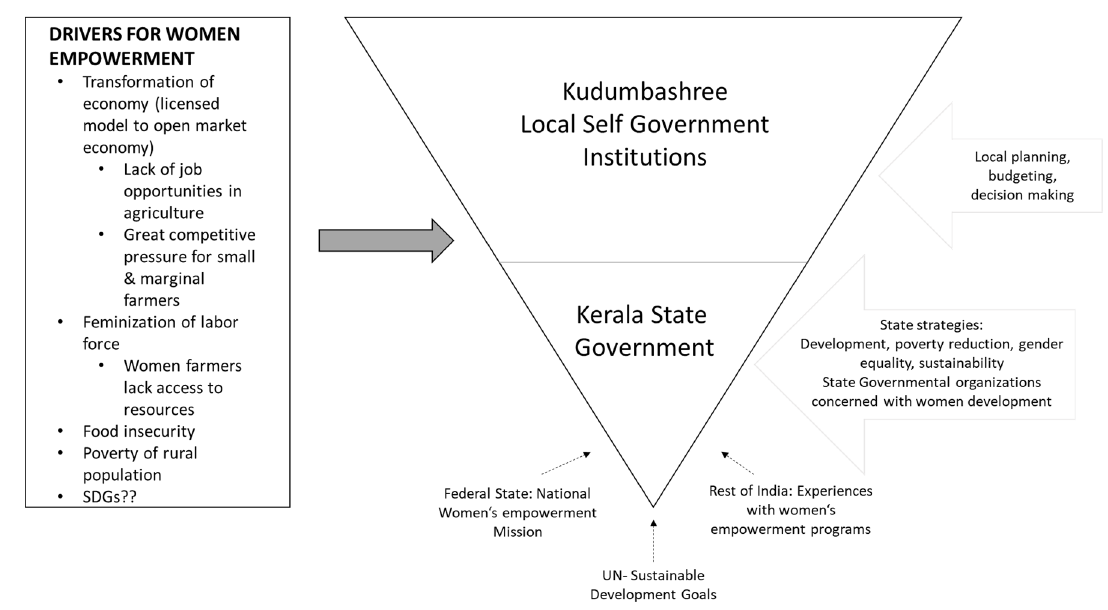
Figure 3. Inverted pyramid of multi-actor engagement framework model for women